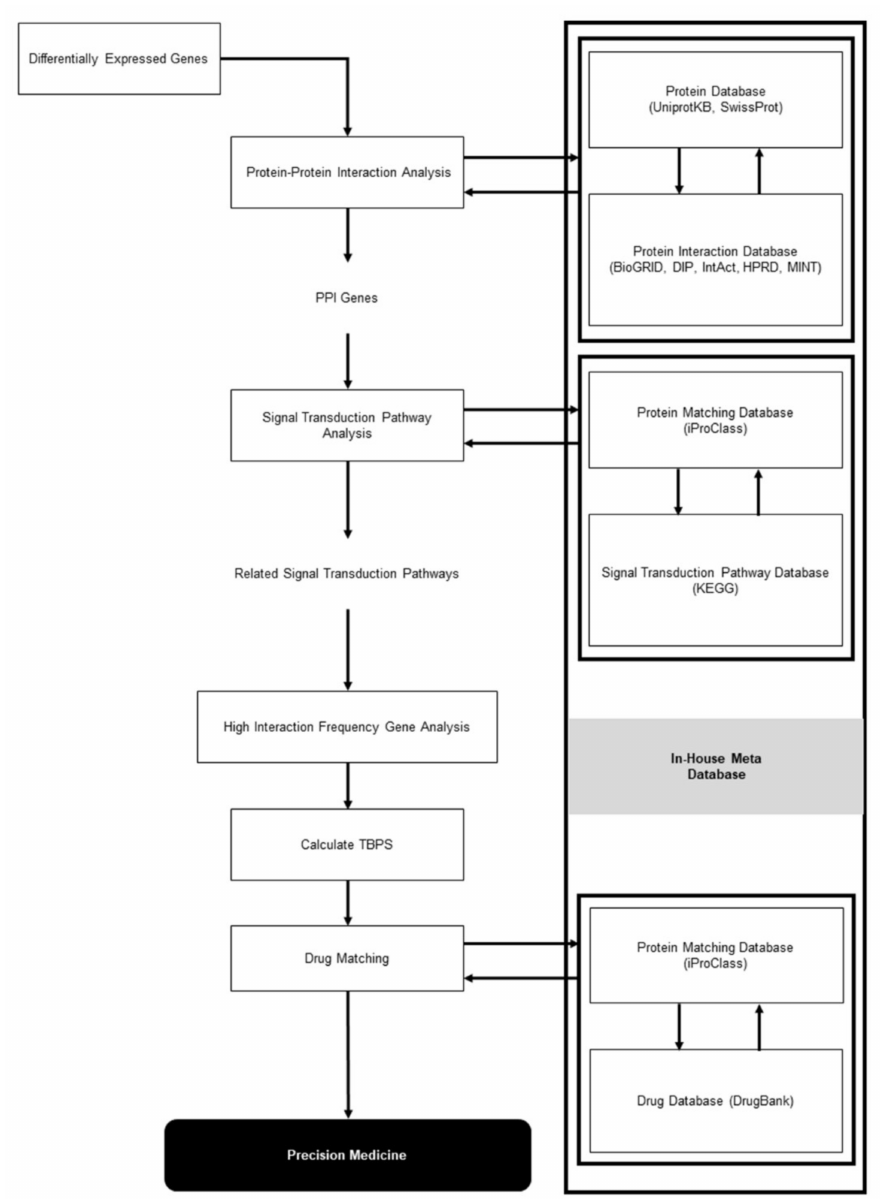
Figure 2. Meta-data analysis